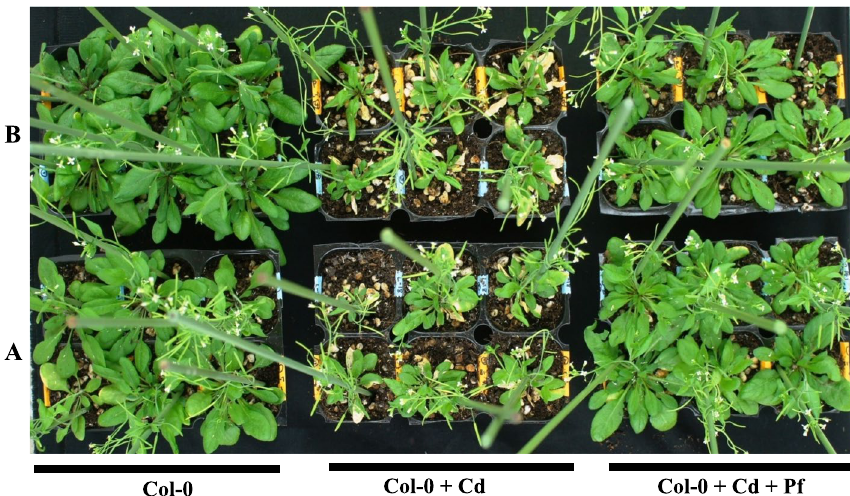
Fig. 3 Col-0: Columbia-0 Arabidopsis line. a Control. b Pseudomonas fluorescens treated. Col-0 1mM. b 2mM. Col-0 Cd Pf: In the presence of Pseudomonas fluorescens cadmium treatment to Arabidopsis plants. a 1mM and b + +